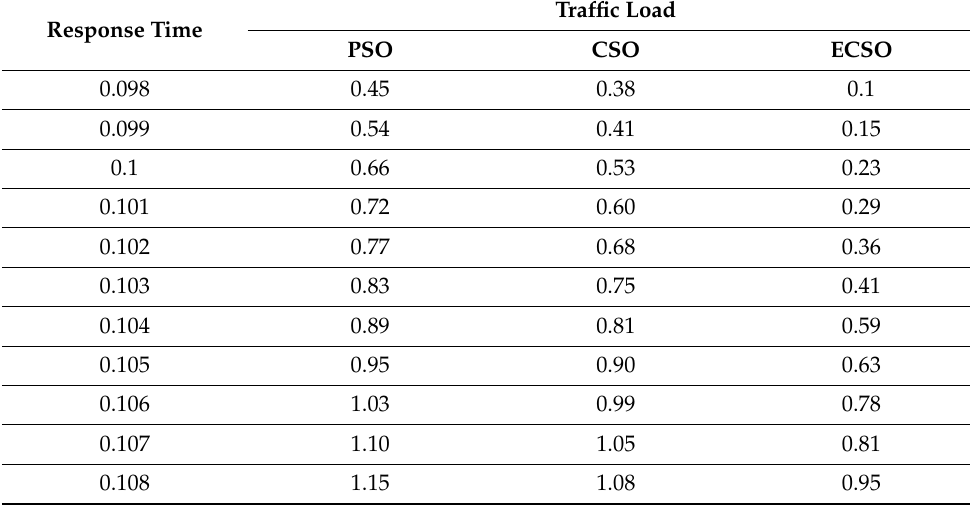
Table 3. Traffic load against response